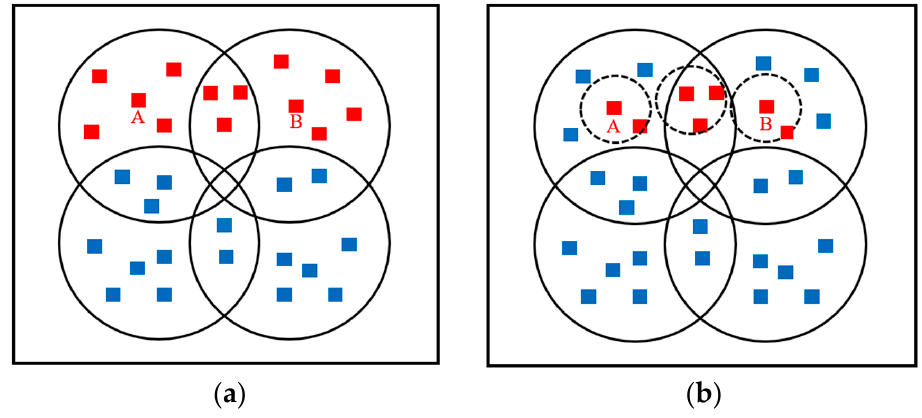
Figure 9. Node working status in WSN and SDN auxiliary systems: ( a ) Working status of nodes in the WSN structure. ( b ) Working status of nodes in SDN auxiliary system. Table 1. Node energy consumption in one day in different deployment